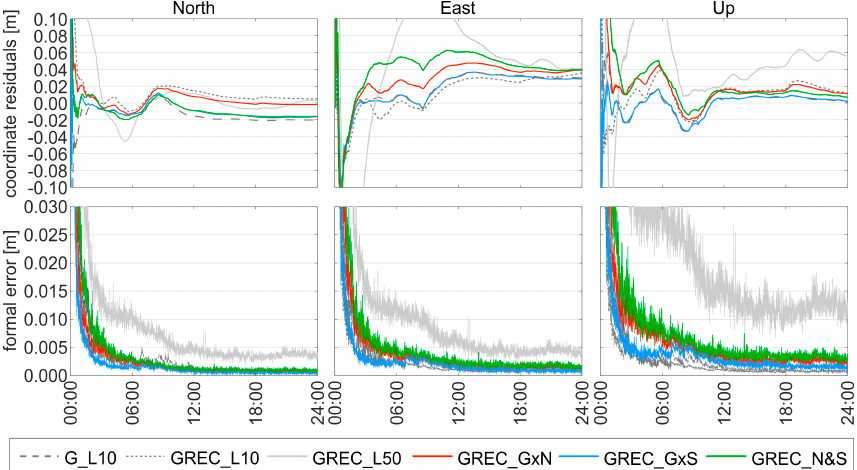
Figure 5. Time series of coordinate residuals and coordinate formal errors obtained from different solutions for station KZN2 during DoY 198, 2017.